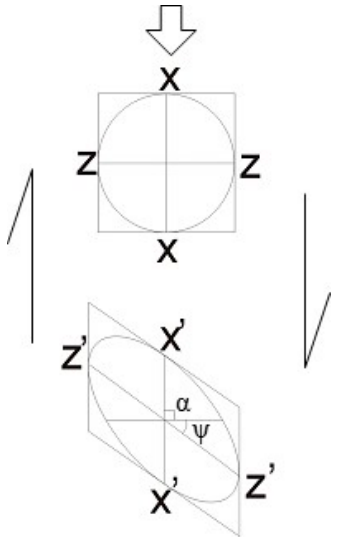
Figure 18. Simple illustration of the longitudinal strains (Z’Z’) produced by simple shear strain. The simple shear is associated here with pure shear related to regional shortening.